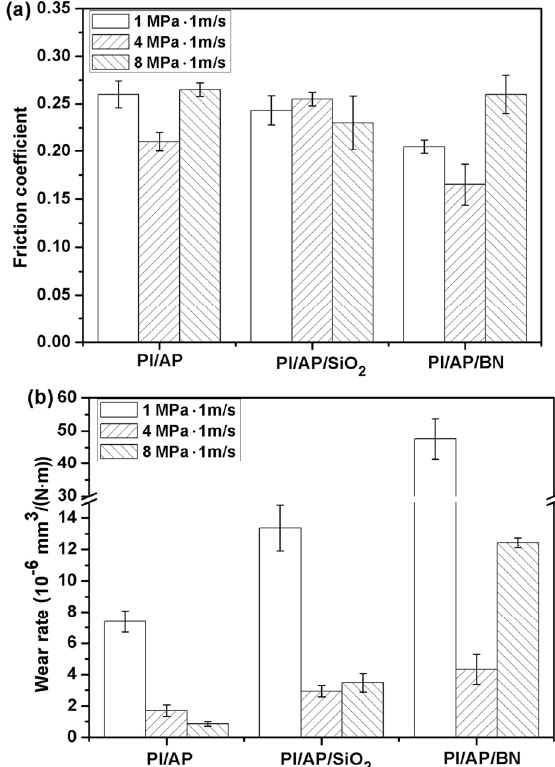
Fig. 5 (a) Average friction coefficients and (b) wear rates of PI/ AP, PI/AP/SiO 2 , and PI/AP/BN when sliding against Al 2 O 3 at 1, 4, and 8 MPa·1m/s.